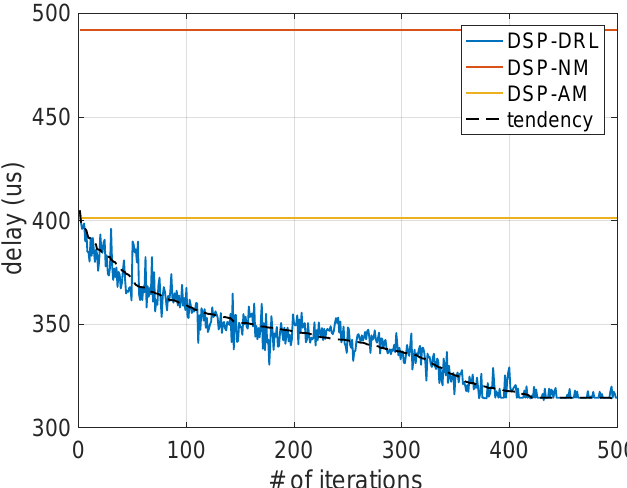
Figure 6. The convergence on total delay of 30 users.